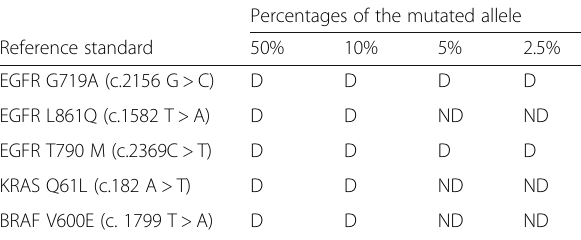
Table 3 MS assay sensitivity tested with reference standard DNA using decreasing percentages of mutated alleles Percentages of the mutated allele